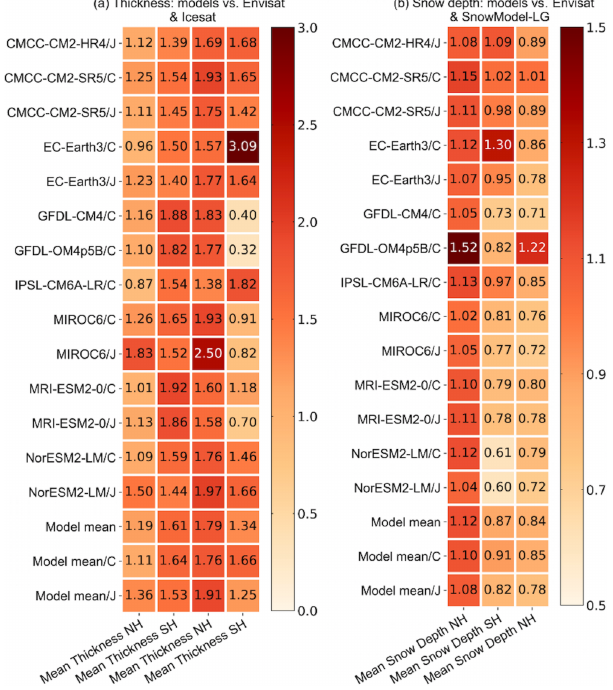
Figure 7. The mean state (a) ice thickness and (b) snow depth metrics during 2003–2007 of 14 model outputs under OMIP1 (/C) and OMIP2 (/J) protocols, 14-model mean (model mean), five- OMIP1-model mean (model mean/C) and five-OMIP2-model mean (model mean/J) from CMCC-CM2-SR5, EC-Earth3, MIROC6, MRI-ESM2-0, and NorESM2-LM. The four columns in (a) corre- spond to ice thickness metrics in both hemispheres compared to the Envisat (first two) and ICESat data (last two), and the three columns in (b) correspond to snow depth metrics compared to the Envisat data in both hemispheres (first two) and the SnowModel-LG data in the Arctic (last one). Lower values indicate better skill.